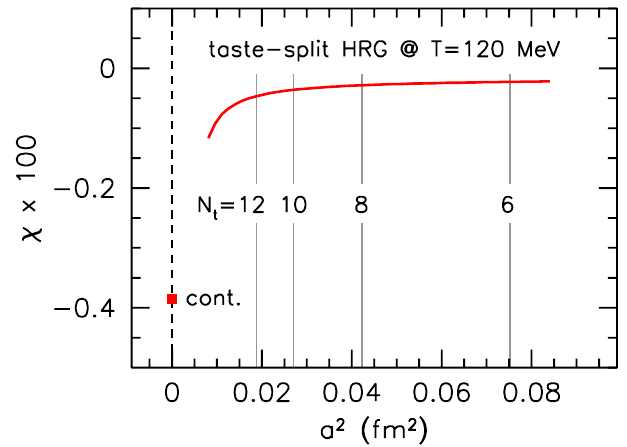
Figure 10 . Lattice artifacts in the susceptibility in a generalized HRG model involving taste split-